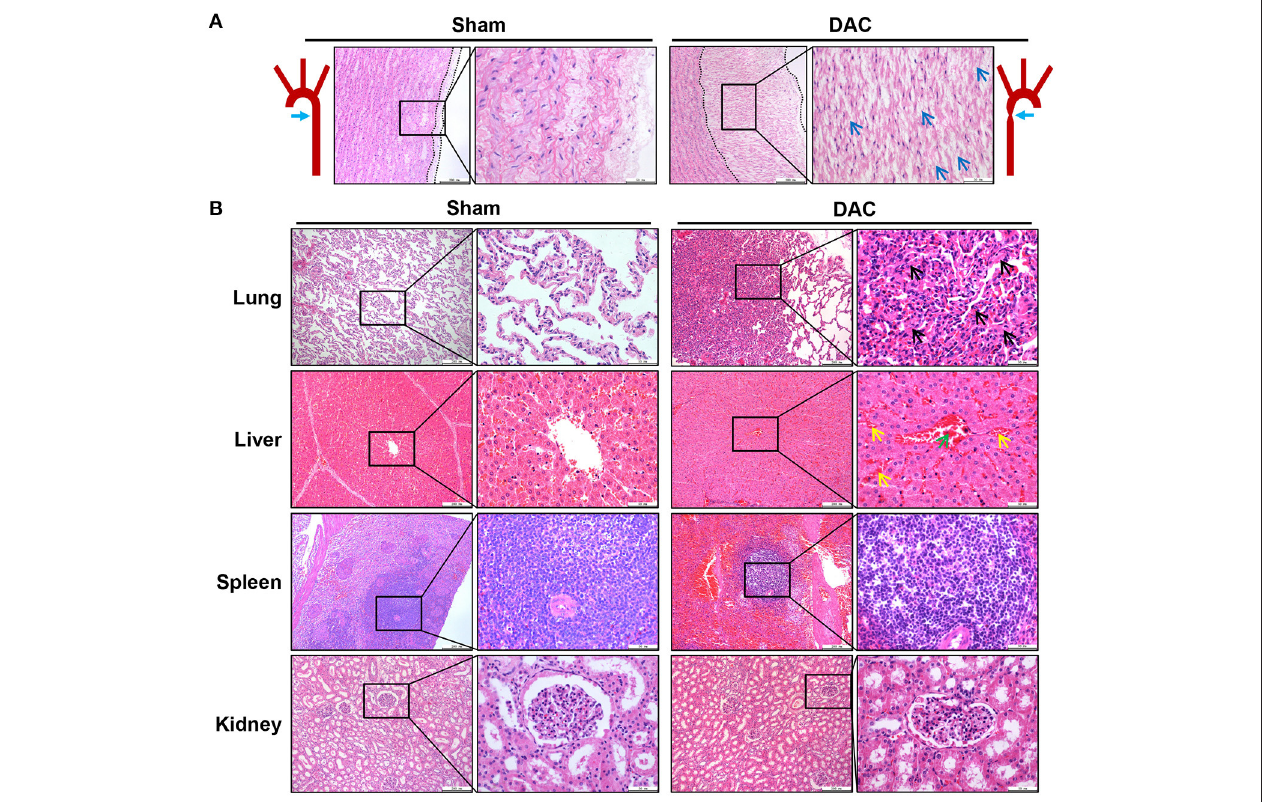
FIGURE 3 | Pathological changes of the aorta (A) and main organs (B) of lungs, livers, spleens, and kidneys of the sham and DAC minipigs. In DAC animals at 12 weeks after surgery, the intima of the proximal aorta displayed hyperplasia, indicated at (A) . The collagen fibers in the subendothelial layer were indicated (blue arrows). The alveolar wall thickened (black arrows). In addition, hepatic tissues displayed hepatocellular oedema, congestion in the central vein (green arrows), and hepatic sinusoids (yellow